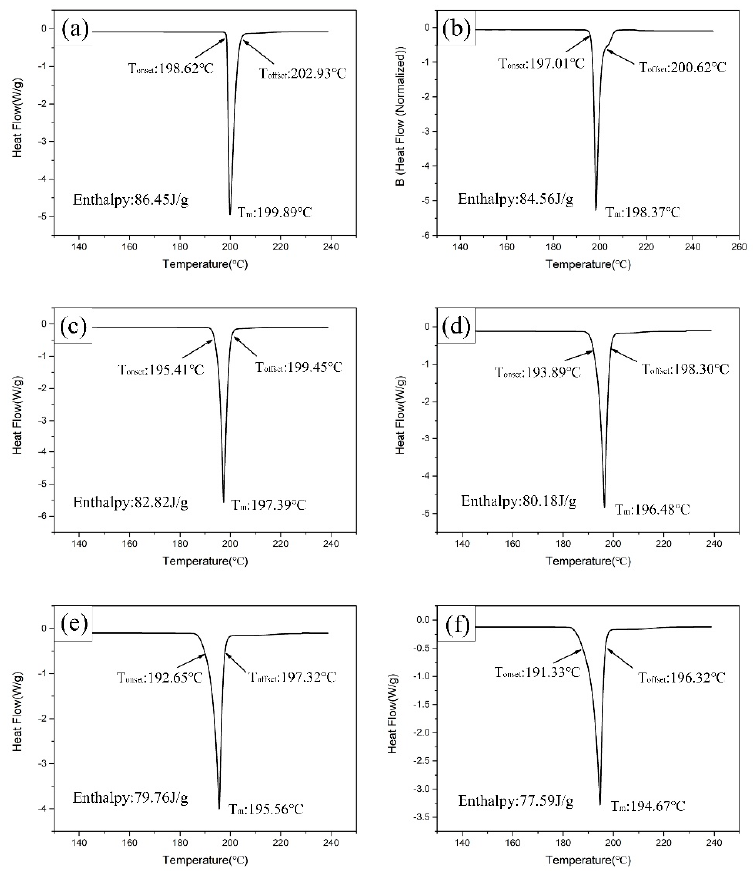
Figure 5. DSC curves of the solder alloys: ( a ) Sn-9Zn; ( b ) S n-9Zn-1Bi; ( c ) Sn-9Zn-2Bi; ( d ) Sn-9Zn-3Bi; ( e ) Sn-9Zn-4Bi; ( f ) Sn-9Zn-5Bi.